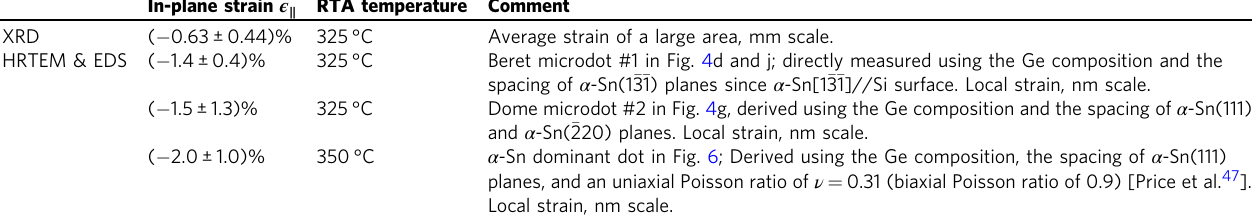
Table 1 Summary of in-plane strain in α -Sn annealed at 325 °C and 350 °C. In-plane strain ϵ ∥ RTA temperature Comment